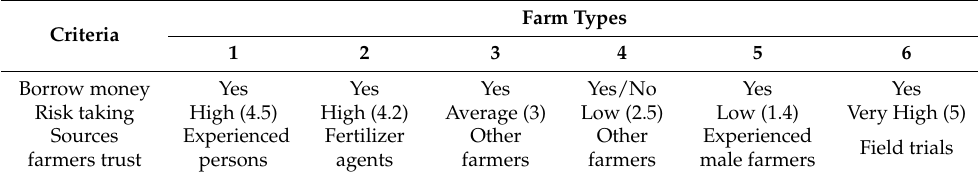
Table 7. Borrowing practices, attitudes to risk and sources of trusted information by different farm